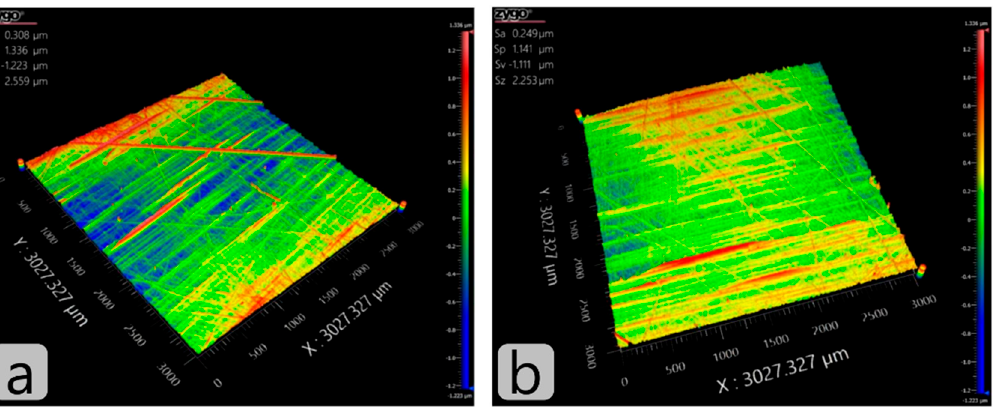
Figure 6. Sample of PA-6 before ( a ) and after ( b ) the process of MR polishing with 15 rps, 5 min polishing time, and magnetic field intensity of 420 kA/m.